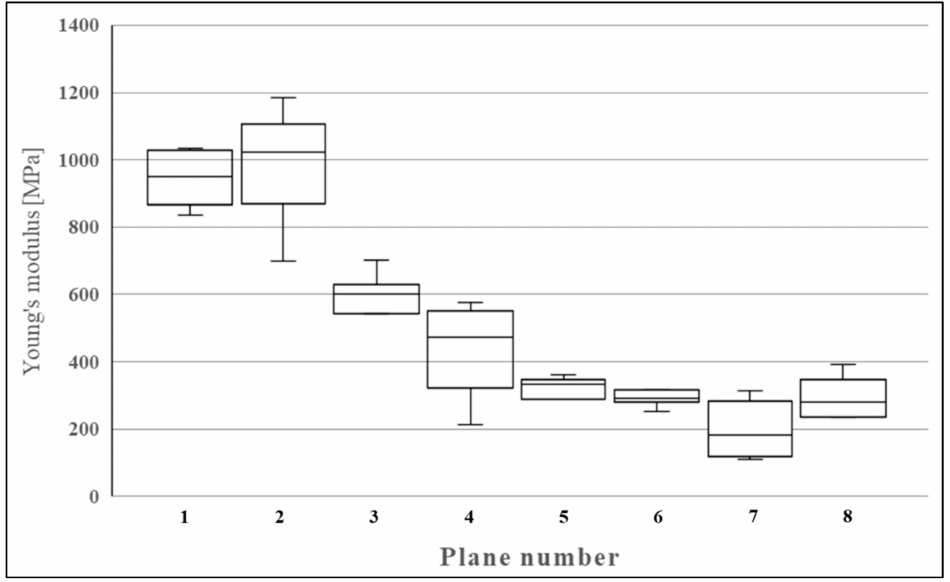
Figure 7. The Young’s modulus measurements at chosen eight planes in the region of interest along the line from the molar area (1) to the area beside the fixing plate